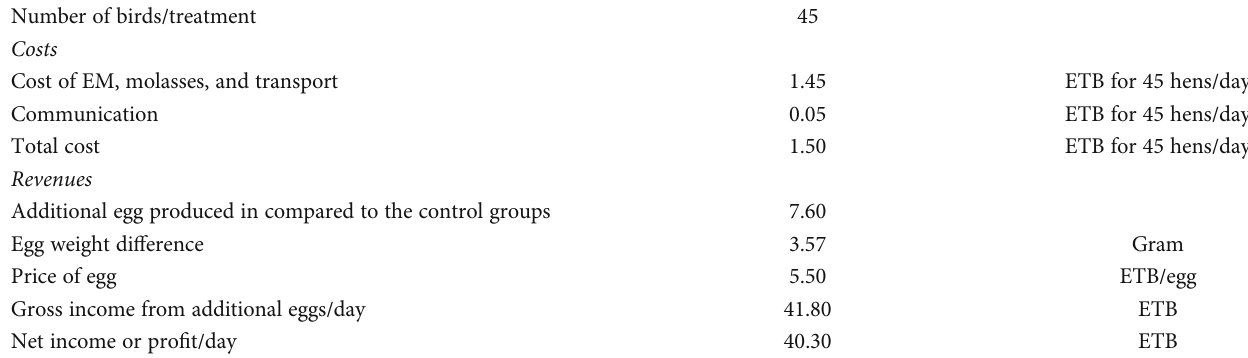
Table 7: Pro fi t analysis of egg production of chickens treated with EM in feed and